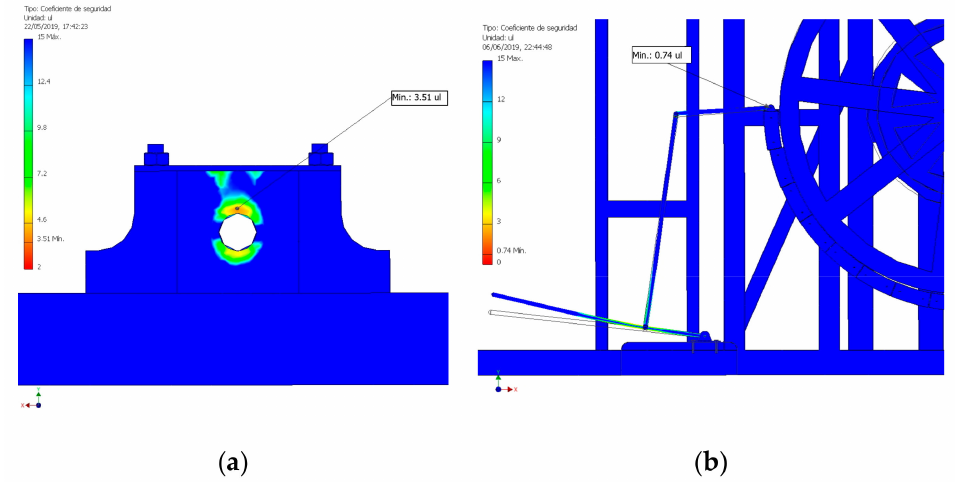
Figure 21. Location of the lowest safety coe ffi cient: ( a ) blockage situation and ( b ) braking situation.